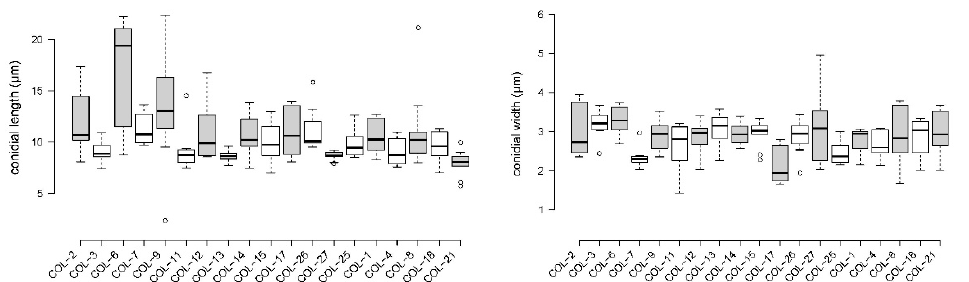
Figure 5. Box plots showing the variation in length and width of conidia produced by Colletotrichum isolates characterized in the current study. Center lines show the medians; box limits indicate the 25th and 75th percentiles, as determined by R software; whiskers extend 1.5 times the interquartile range from the 25th and 75th percentiles; outliers are represented by dots. n = 5 sample points.